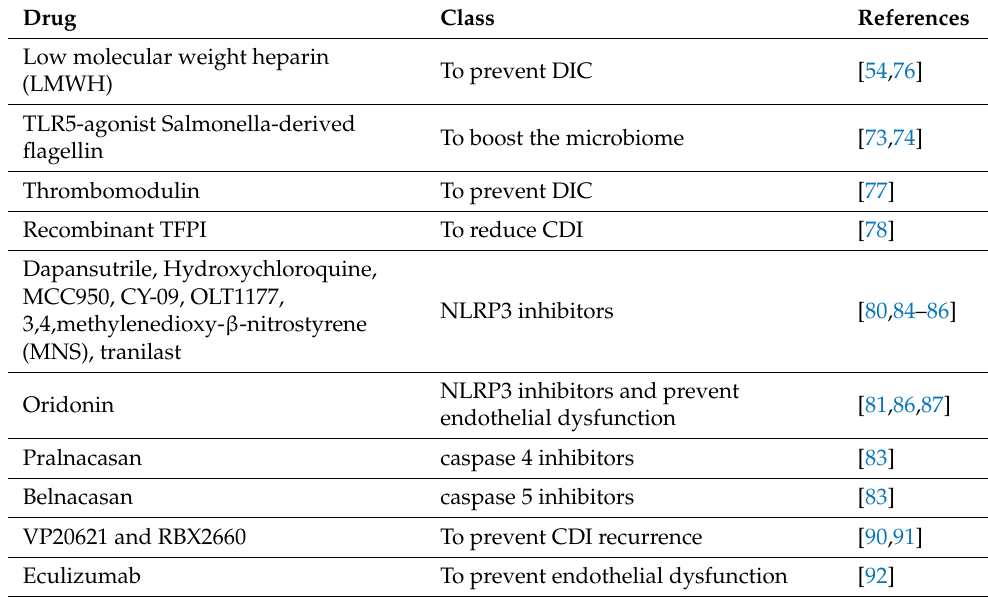
Table 1. New frontiers of therapy for C. difficile infection-related inflammasome activation and coagulation